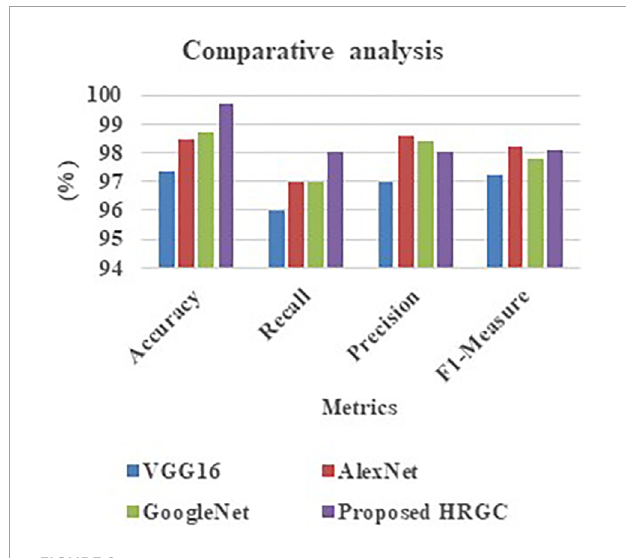
FIGURE 2 Evaluation of Recall,F1, and other quality